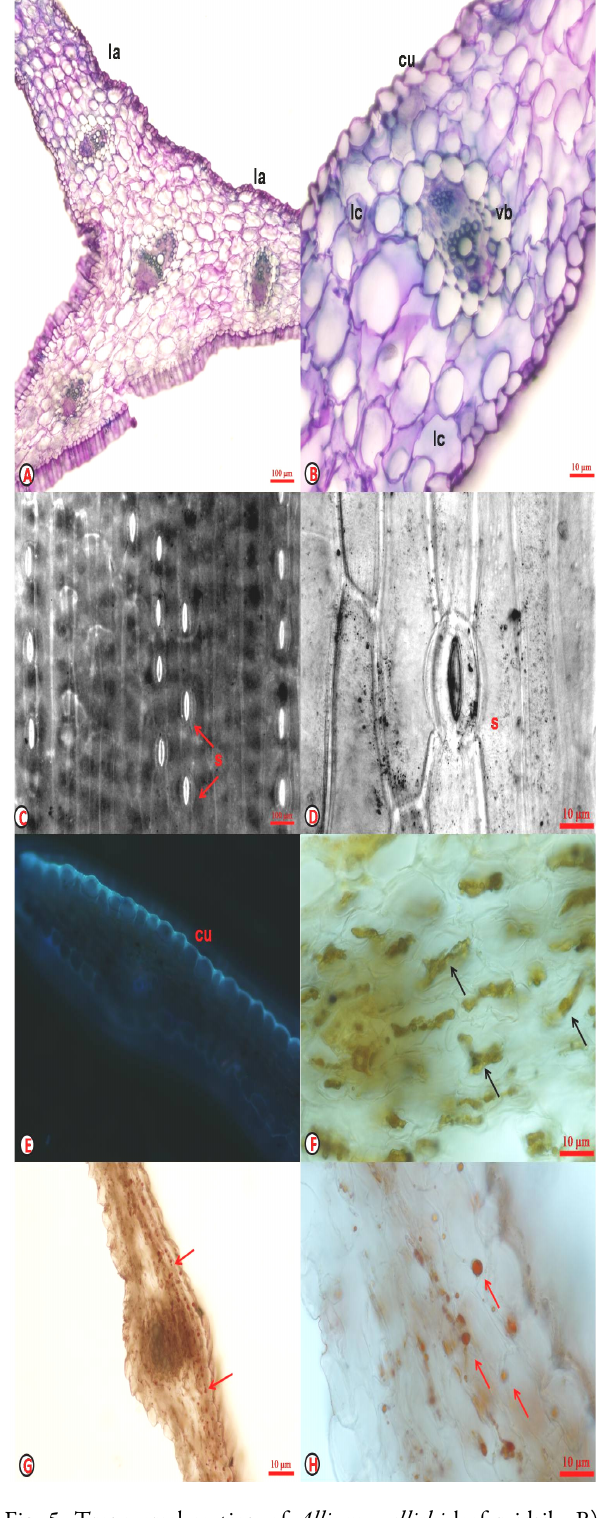
Fig. 5. Transversal section of Allium wallichi leaf midrib: B) T.S. of a portion of leaf lamina; C) Leaf peel showing the stomatal arrangement; D) Leaf peel showing magnified image of a stoma. E) Cuticle layer (also with suberin) observed under UV; F) Presence of alkaloid (black arrow); G-H) Presence of lipid droplets (red arrow); cu - cuticle layer; la - lamina; lc - lactiferous cell; vb - vascular bundle, s - stomata